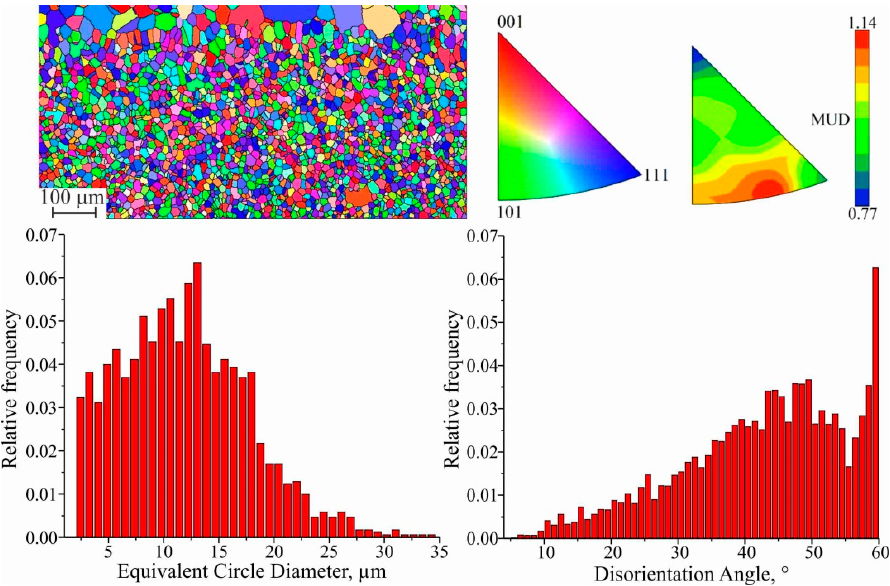
Figure 13. EBSD map fragment; grain size; disorientation; scattered and contoured IPFs for I area.